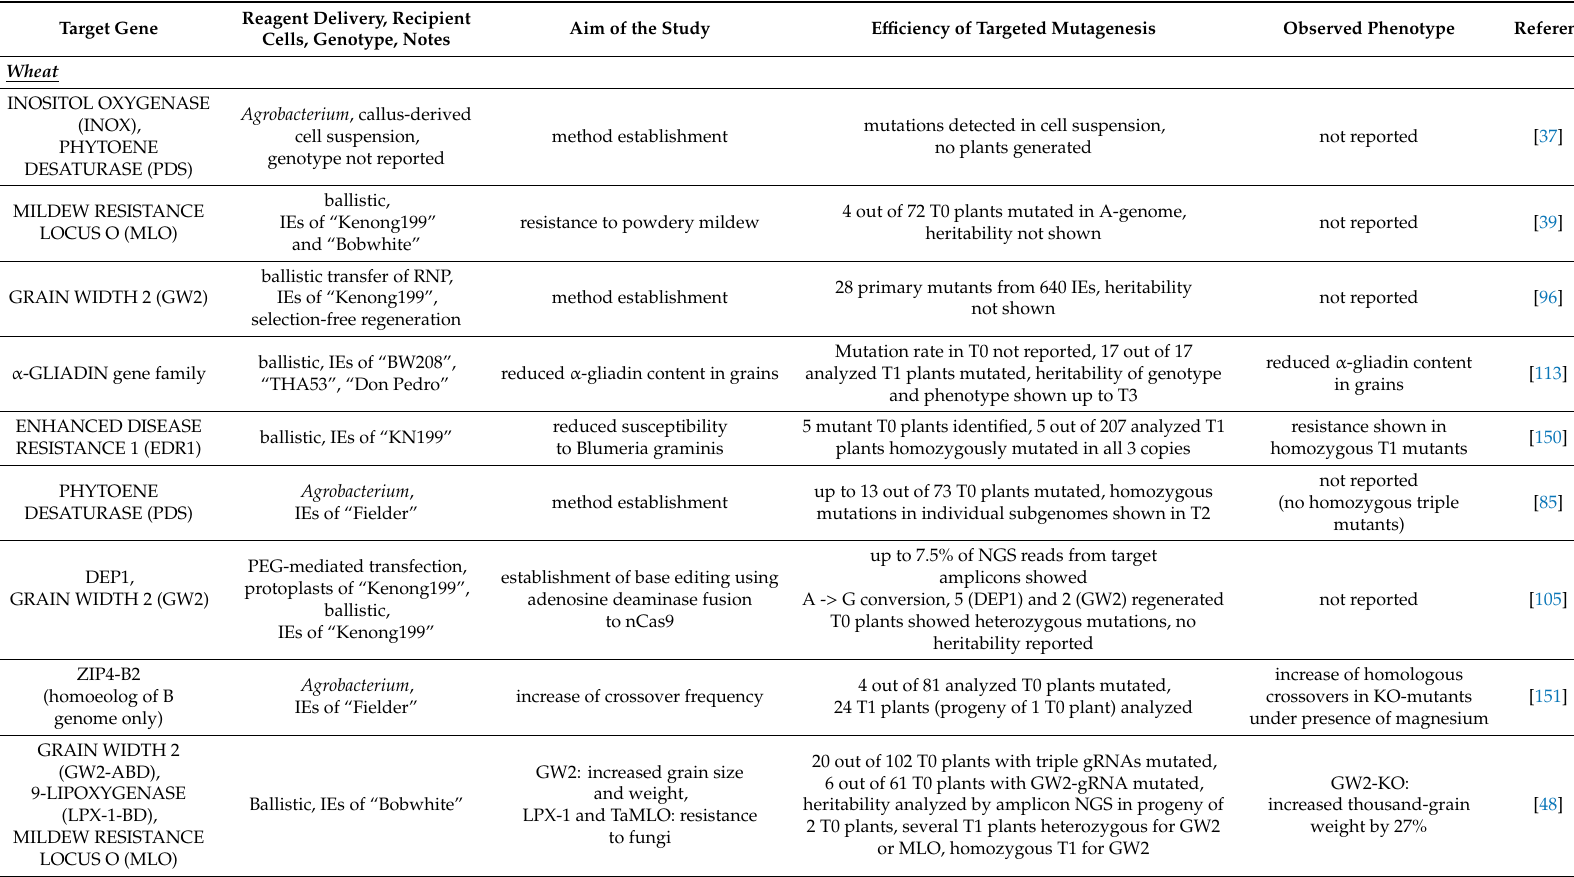
Table A1. Survey of studies employing Cas endonuclease technology in wheat and barley. If not stated otherwise, gRNA and Cas9 were delivered as transgenes, the outcome was site-directed mutagenesis (i.e., random InDels at the target sites), and genetic modifications were shown to be heritable. IEs: immature embryos, RNP: gRNA / Cas9